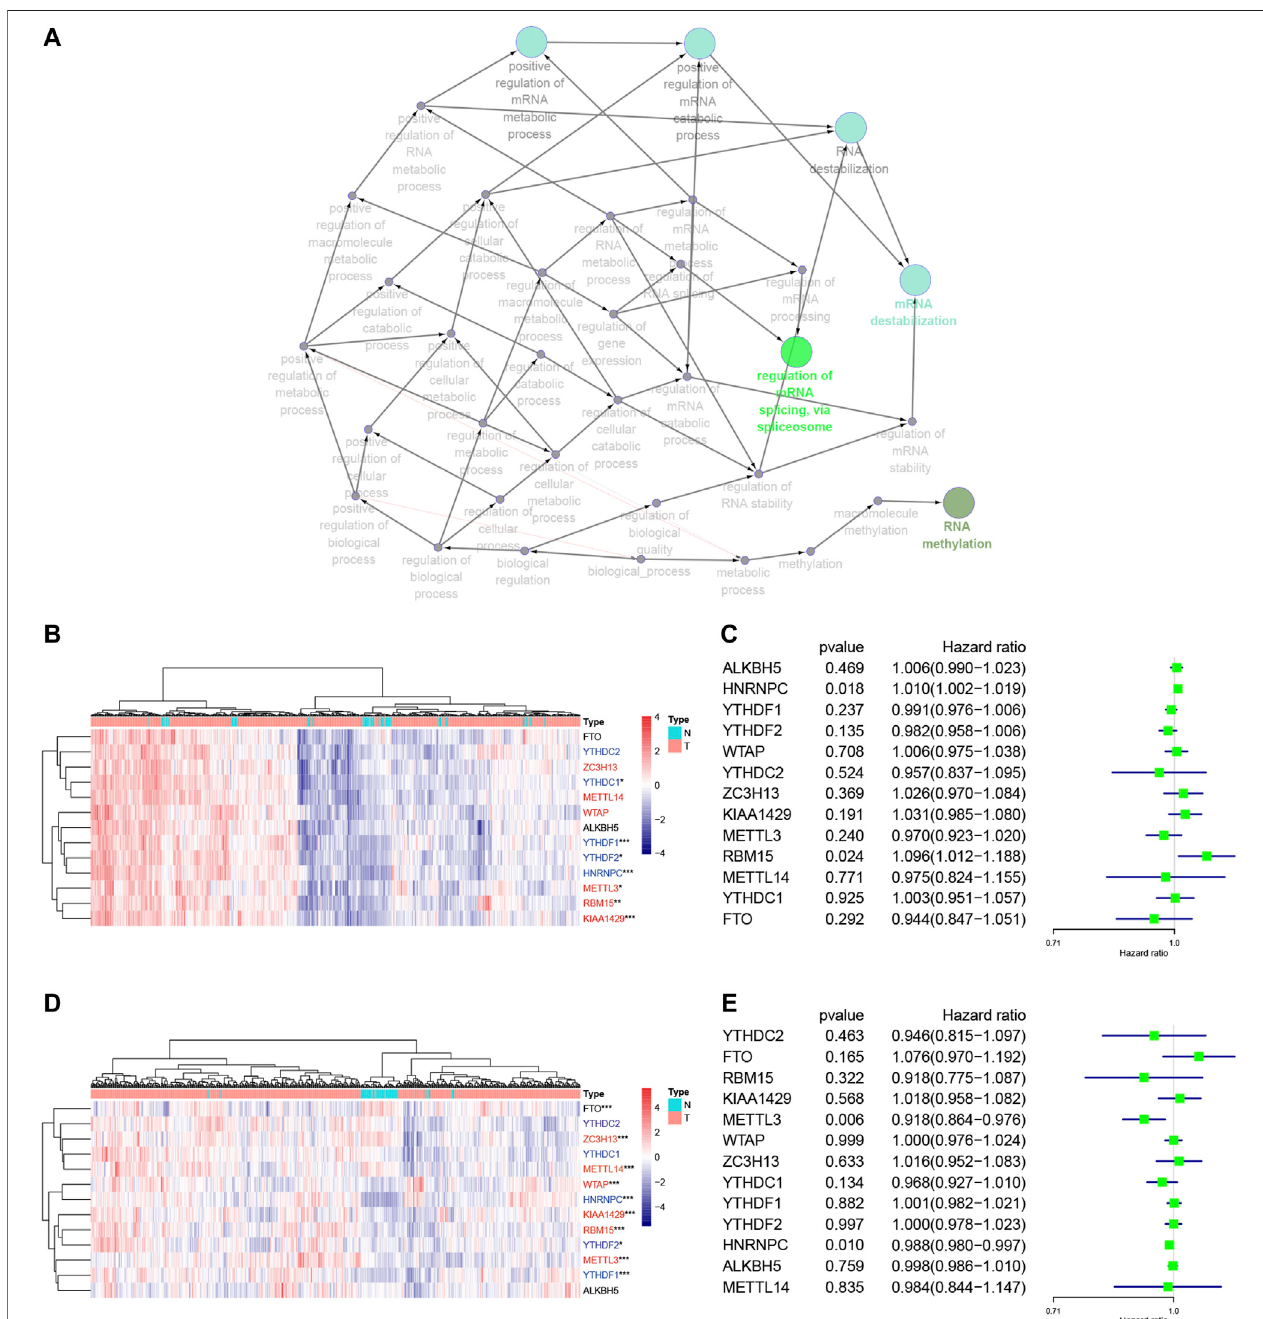
FIGURE 2 | Association of m6A RNA methylation regulatory genes with NSCLCprognosis. (A) The GO terms and KEGG enrichment pathway analysis of the m6A regulator gene, the different colors represent the different pathways. (B) Differential expression of these 13 m6A RNA methylated regulator genes in LUAD (red: “ writer ” ; blue: “ readers ” ;black: “ erasers ” ). (C) ForestplotoftheunivariateCoxregressionanalyticdata.The13m6ARNAmethylationregulatorsinLUADwereanalyzedusingthe univariate Cox regression and the data are plotted using the forest plot. (D) Differential expression of these 13 m6A RNA methylated regulators in LUSC (red: “ writer ” ;blue: “ readers ” ;black: “ erasers ” ). (E) ForestplotoftheunivariateCoxregressionanalysis.The13m6ARNAmethylationregulatorsinLUADwereanalyzedusing the univariate Cox regression and the data are plotted using the forest plot. *** p < 0.001, ** p < 0.01, and * p < 0.05. The KEGG, Kyoto Encyclopedia of Genes and Genomes; GO, Gene Ontology; LUAD, lung adenocarcinoma; LUSC, lung squamous cell carcinoma; m6A, N6-methyladenosine; N, Normal; T, Tumor.